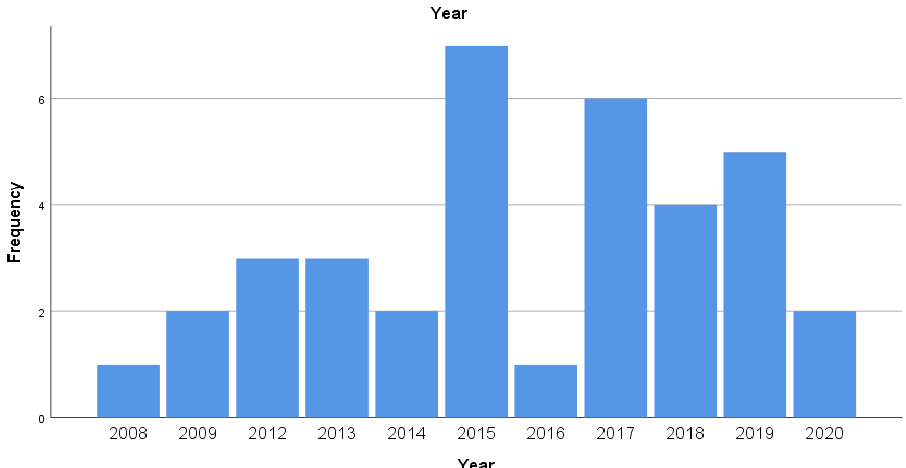
Figure 1. Number of homicide-suicide incidents per year from 2008 to 2020.